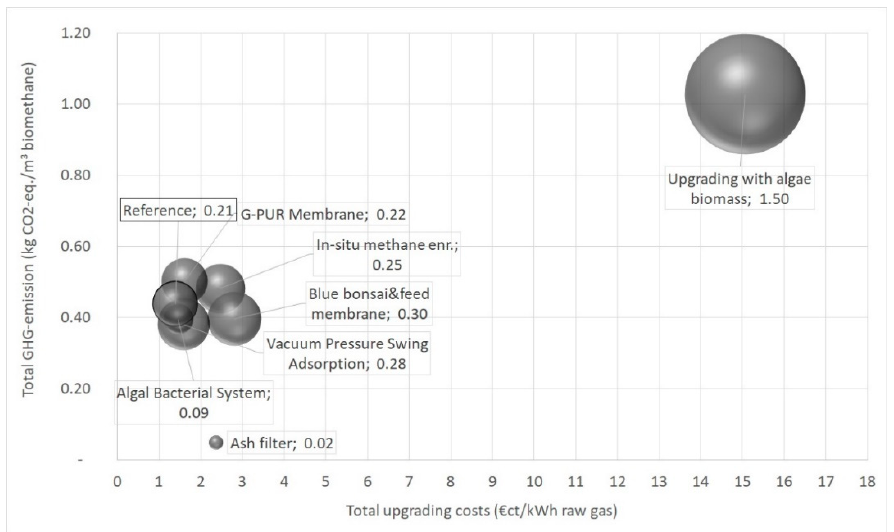
Figure 10. Multi-indicator assessment for upgrading technologies (surface area of bubble represents Multi-indicator assessment for upgrading technologies (surface area of bubble electricity demand in kWh/m³ raw gas of technologies which is also displayed after the technology represents electricity demand in kWh/m 3 raw gas of technologies which is also displayed after name). the technology